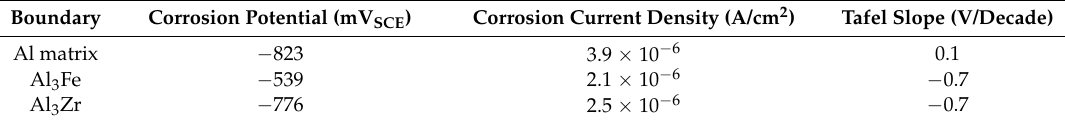
Table 4. Conditions of each IMP’s distributed model.